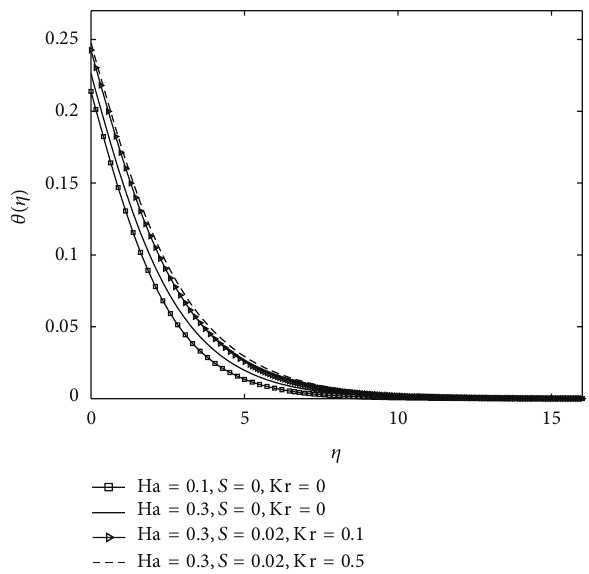
Figure 8: Temperature profiles for different values of Ha, 𝑆 , and Kr for Gr = 0.1 , Gc = 0.1 , Sc = 0.62 , Bi = 0.1 , Nc = 0.01 , and Pr = 0.72